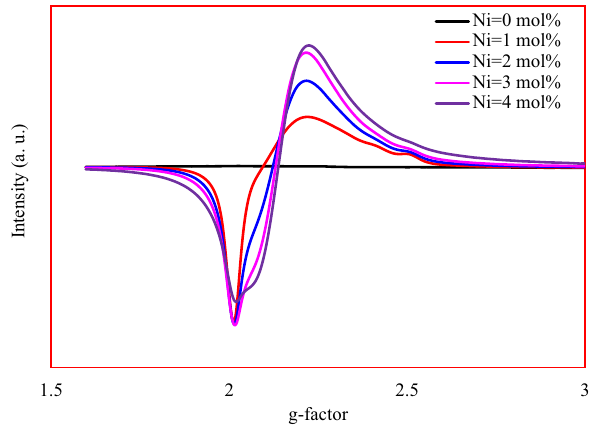
Figure 6. EPR spectra of the studied glasses.